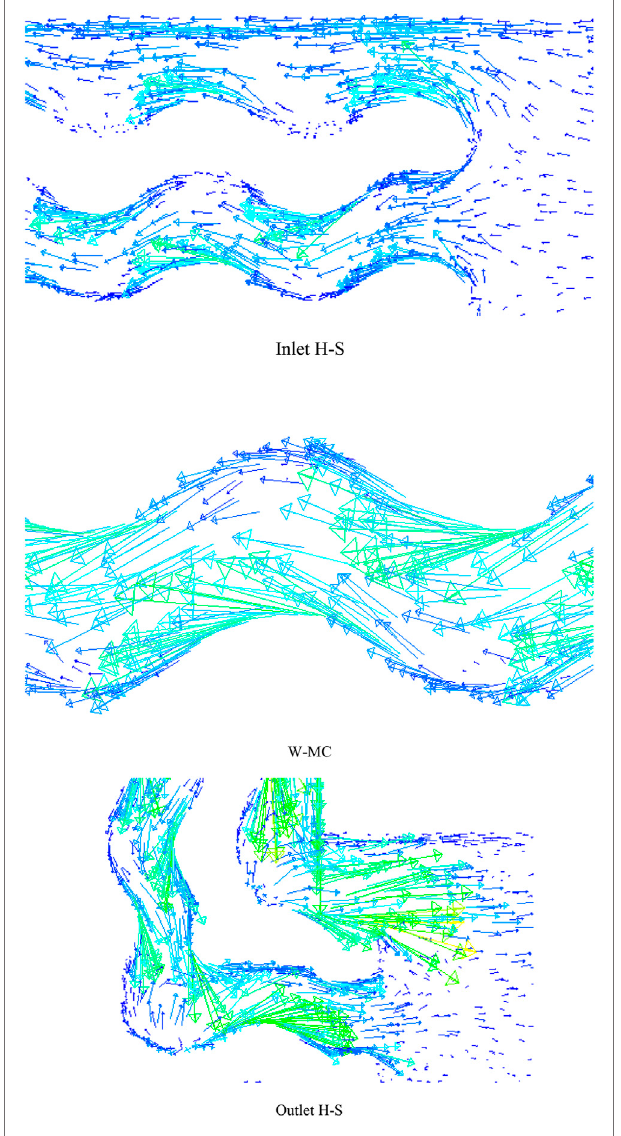
FIGURE 5 | Velocity vector of the NF fl ow for Re (cid:1) 1800.